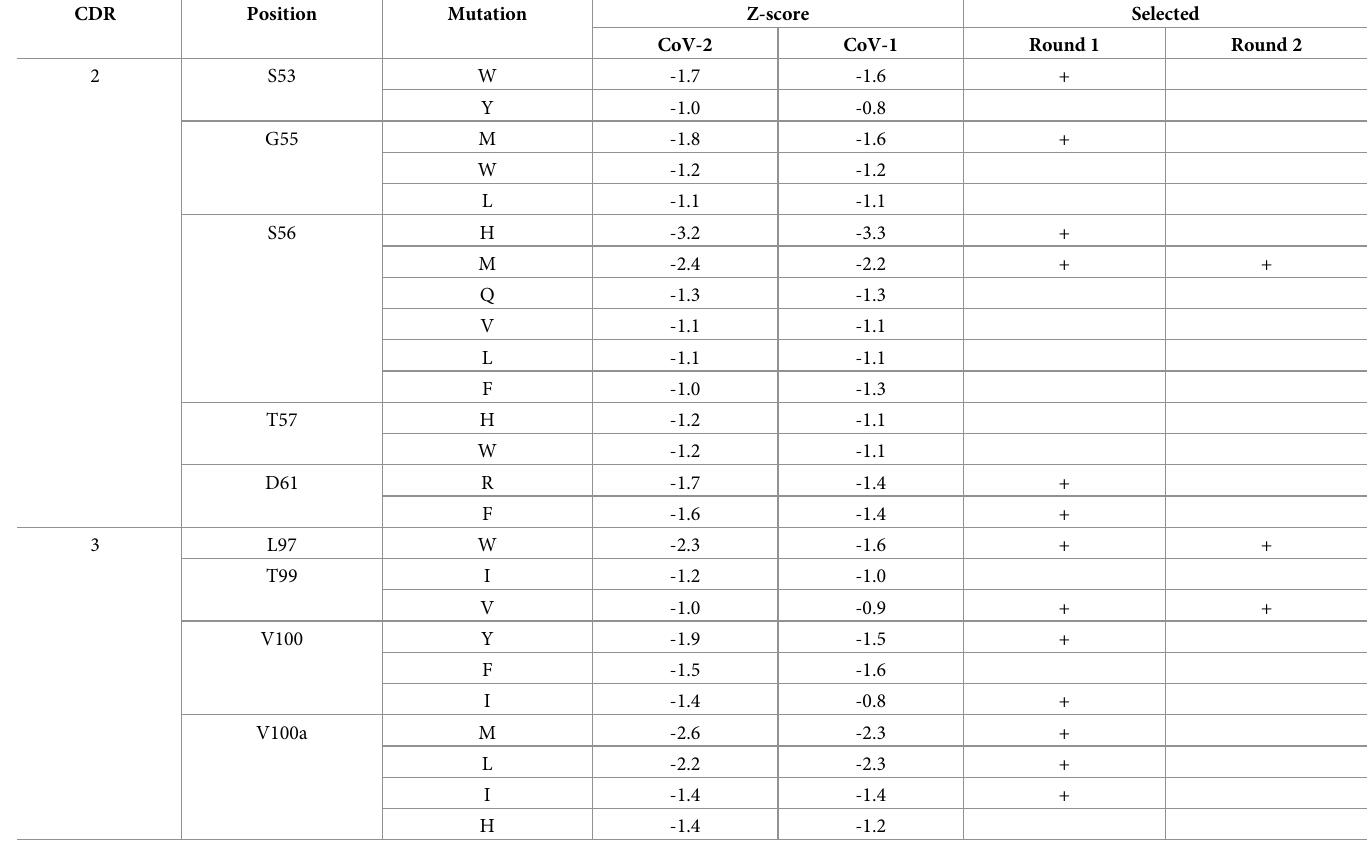
Table 1. ADAPT consensus Z-scores used in VHH-72 mutation